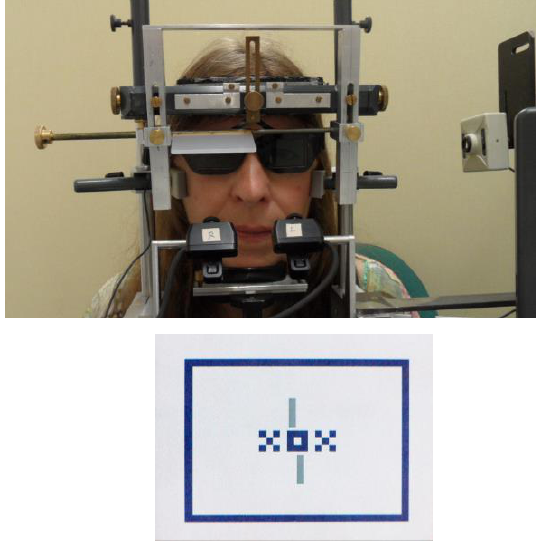
Figure 2: Upper graph: Observer in the adjustable headrest with rests for the chin and the forehead; the cheekbones were fixed to prevent horizontal head movements; a flexible band around the head held the observer in the headrest. Shutter glasses provided dichoptic viewing of the nonius lines. The EyeLink II cameras had an unobstructed view of the eyes below the shutter glasses. The knob (at the left) allowed to move an occluder in front of each eye for the monocular calibration. The side-view camera (at the right) gave a video image that allowed placing the eye at the correct position with respect to viewing distance and height. Lower graph:Visual stimulus with a central and peripheral binocular fusion target (XOX and outer frame) and dichoptic nonius